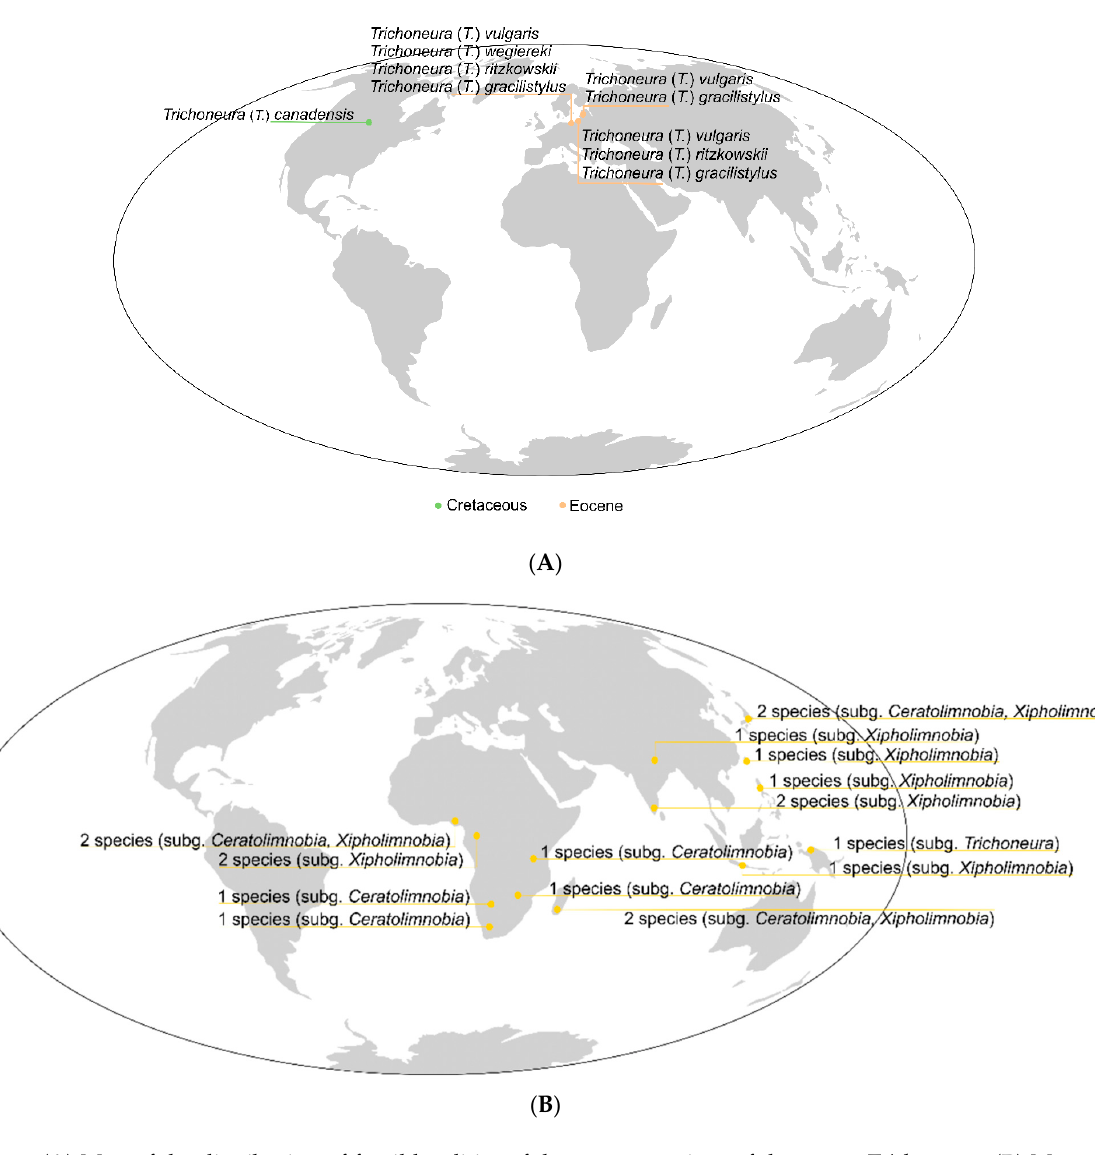
Figure 6. ( A ) Map of the distribution of fossil localities of the representatives of the genus Trichoneura. ( B ) Map of the distribution of the representatives of the genus Trichoneura in recent fauna (the data provided according to [2]). A. the colors of the lines that indicate fossil localities are used according to International Chronostratigraphic Chart v.2020.03 (https://stratigraphy.org/chart) (Accessed on 29 April 2021).